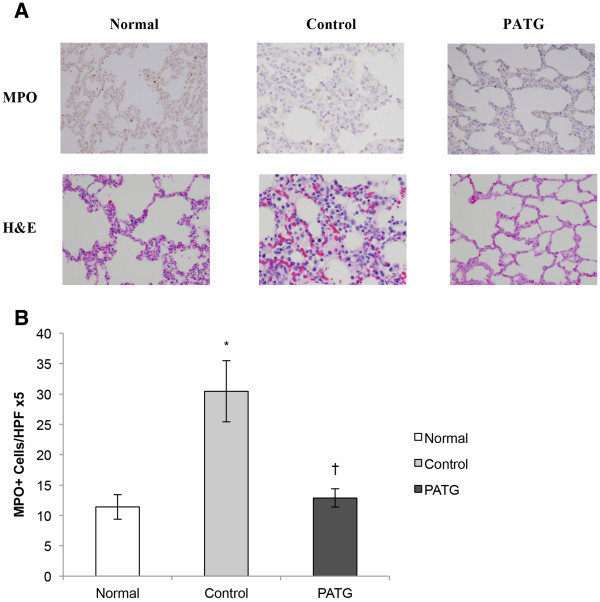
Lung tissue neutrophil counts at time of necropsy.A) Representative histology pictures of normal, control and PATG tissue. B) Quantification of MPO+ cell reactivity. * indicates p < 0.05 compared to normal, unmanipulated tissue. † indicates p < 0.05 compared to control group. Data is depicted as mean ± SEM.